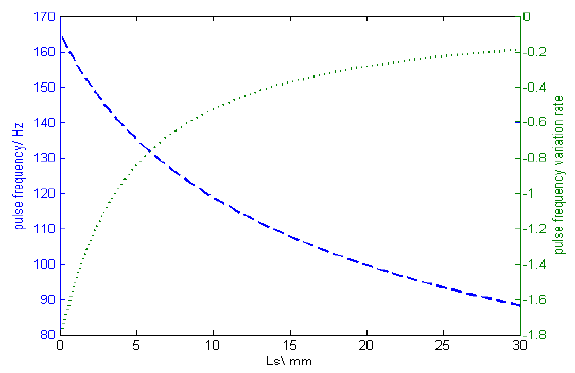
Figure 3 . Stickout effect on pulse frequency. Figure 3. Stickout effect on pulse